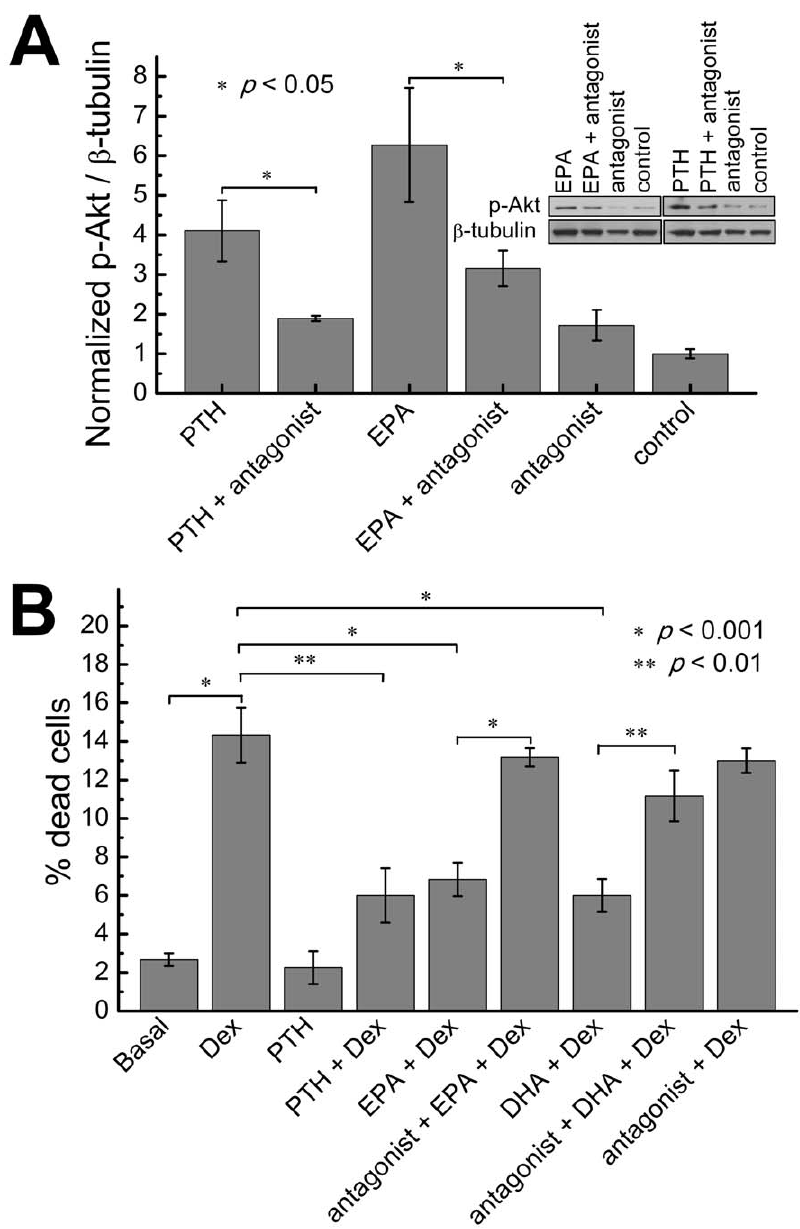
Figure 7. EPA and DHA (A) stimulate Akt phosphorylation and (B) inhibit dexamethasone-induced osteoblast cell death. (A) Phosphorylated Akt levels in MC3T3-E1 cells serum-starved for 4 h and then preincubated with 1 m M of PTH1R antagonist [Leu 11 ,D-Trp 12 ]PTH-rP(7– 34) for 30 minutes followed by 1 m M of LCPUFAs or 10 nM PTH treatment for 5 minutes. (B) Mechanism of the suppressive effect of LCPUFA on cell death in culture of MC3T3-E1 cells. Cultures were maintained for 6 hours in the presence of dexamethasone (Dex) without or with preincubations with 1 m M PTH1R antagonist [Leu 11 ,D-Trp 12 ]PTH-rP(7–34) for 30 minutes followed by exposure to 1 m M of LCPUFA or 10 nM of PTH for 1 hour. Dead cells were enumerated by trypan blue staining. Data represents the mean of at least 6 independent